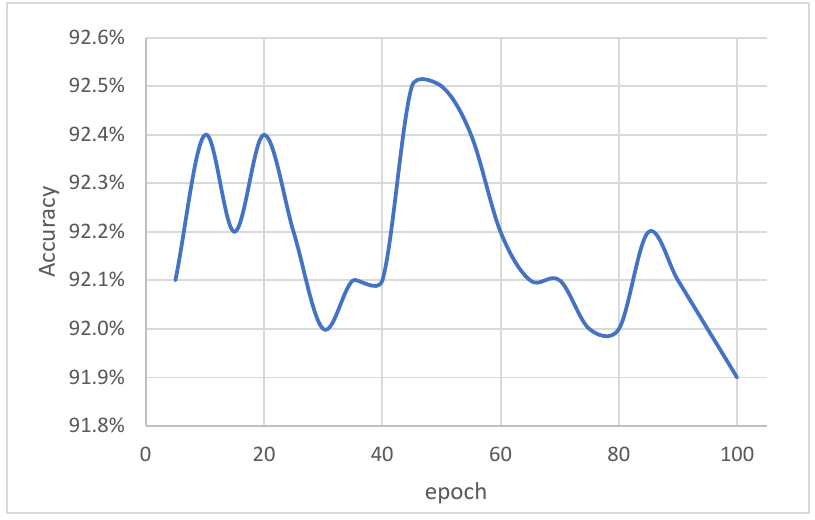
Figure 3. The accuracy of the proposed multimodal model in the first step of Task 2. Table 12. Confusion matrix of the three models on Task 2.